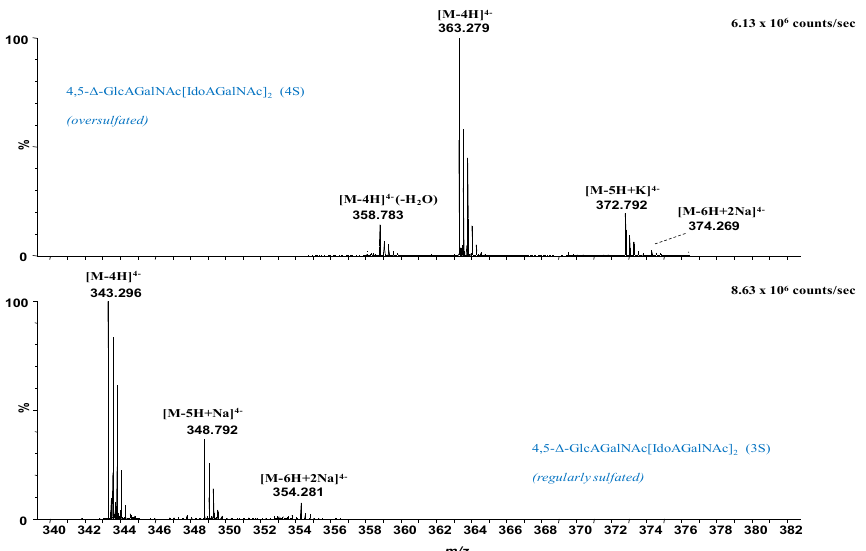
Figure 5. Extracted (-) nanoESI IMS mass spectra of quadruply charged tri- and tetrasulfated 4,5- Δ -GlcAGalNAc[IdoAGalNAc] 2 from the corresponding areas indicated in Figure 2. n S-number of SO 3 groups. Table 1. Assignment of the major ions of CS/DS hexasaccharide fraction detected by IMS MS. n S-number of SO 3 groups.